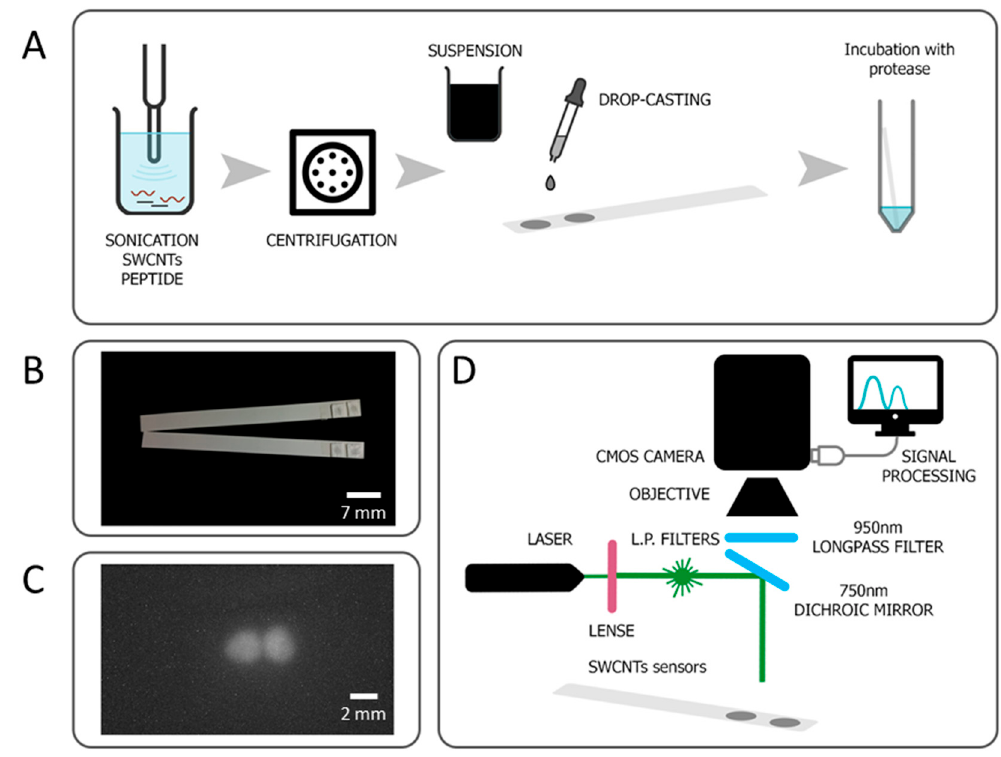
Figure 1. Developed sensor for trypsin detection. ( A ) Sensor preparation scheme, where two replicates of the same sensor are deposited on the same strip. ( B ) Photo of the prepared sensors strips. ( C ) Photoluminescence of the sensors, as captured with a CMOS camera. ( D ) Scheme of the optical setup for signal detection. Not to scale.